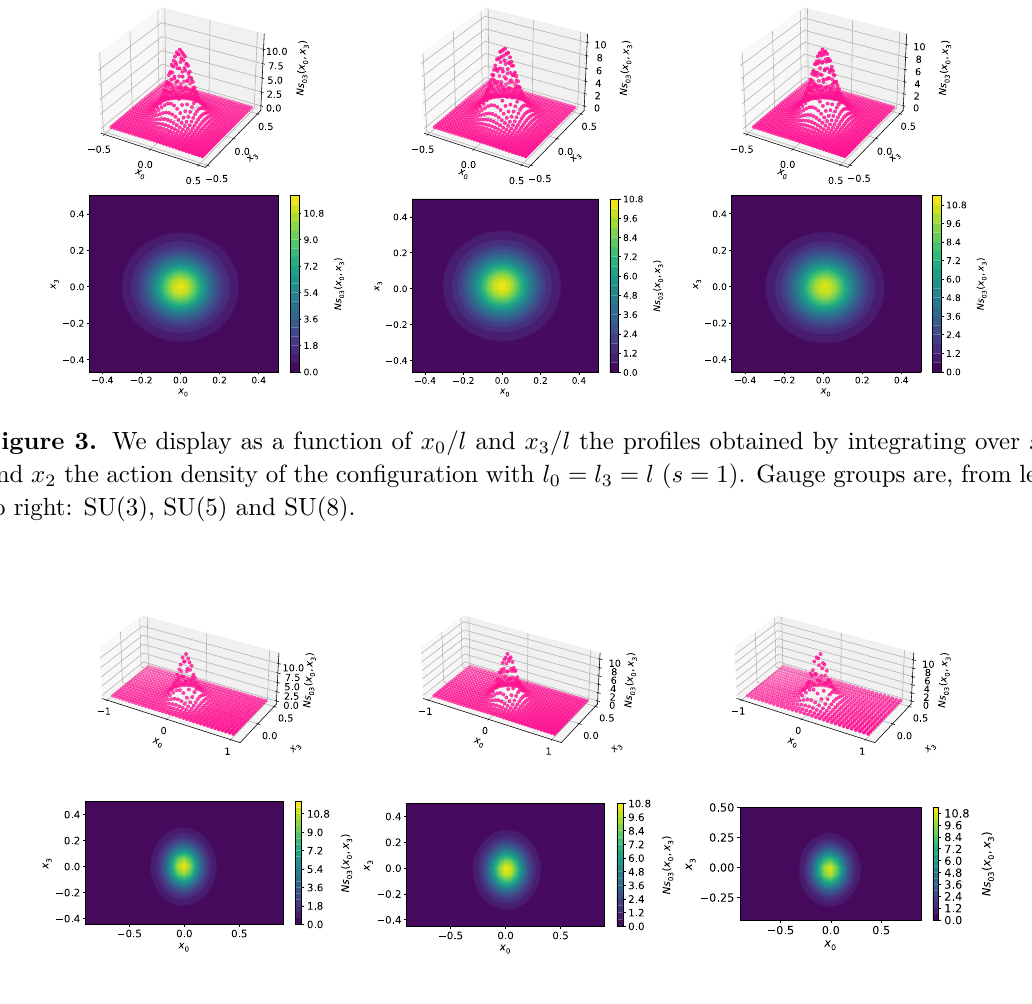
Figure 4. The same as in figure 3 but for l 0 = 2 l 3 = 2 l ( s = 2